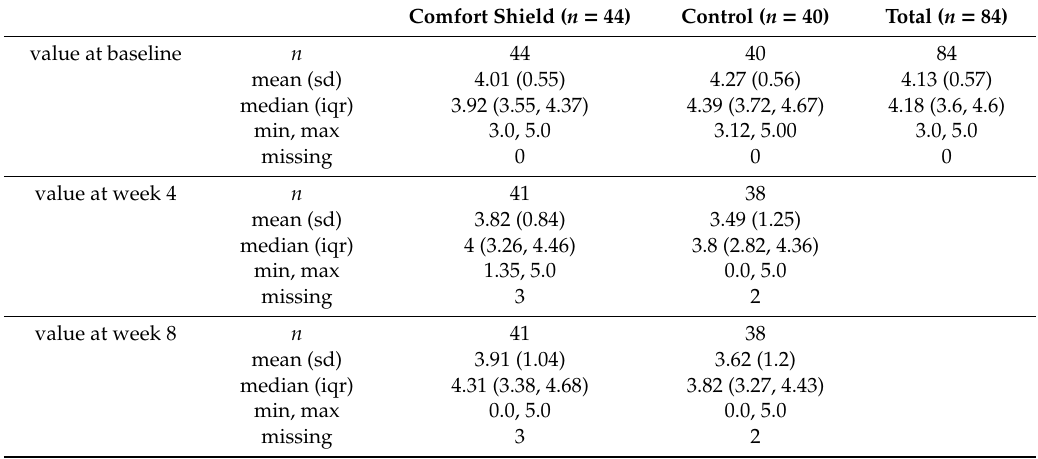
Figure 2. Mean ( ± SD) of corneal fluorescein staining (CFS) (central reading value, transformed into grade exact value) by group according time—PPS ( n = 84). Open circles = Comfort Shield group, filled squares = control group. Table 3. CFS: Value at baseline and at each post-baseline visit—PPS ( n = 84)—Descriptive analysis, by group.